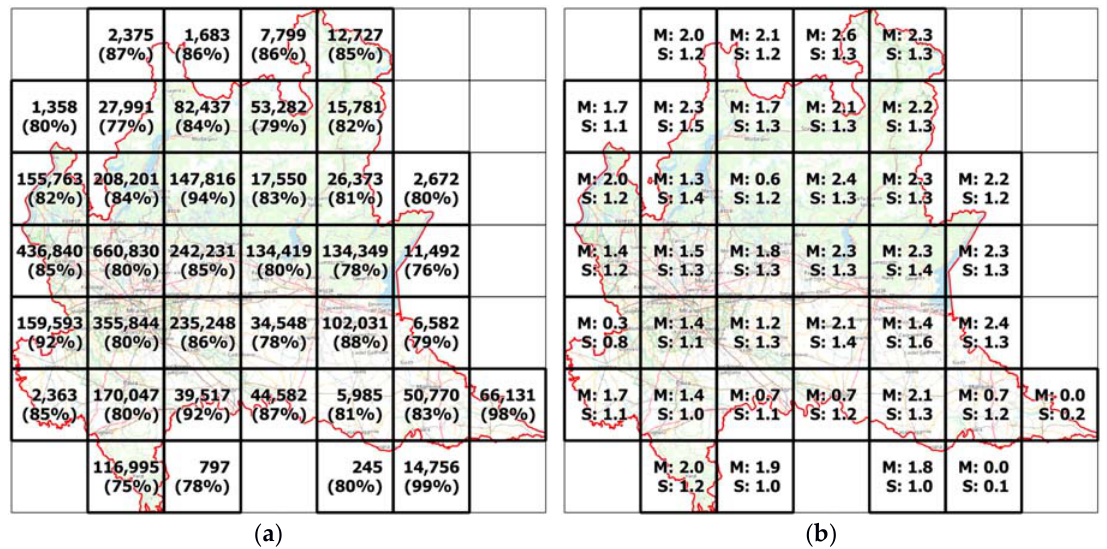
Figure 5. Homologous points detected without transformation in the search process. ( a ) Number and percentage of detected points with respect to the total number of OSM points; ( b ) mean (M) and standard deviation (S) in meters of the distance of the homologous points.